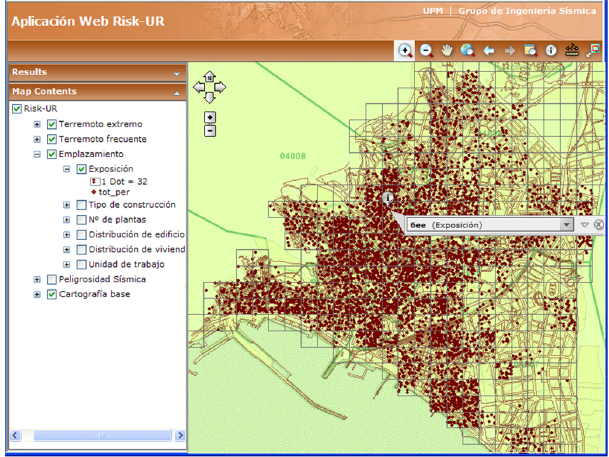
Fig. 8. Web visualiser image showing the distribution of the popu- lation within the